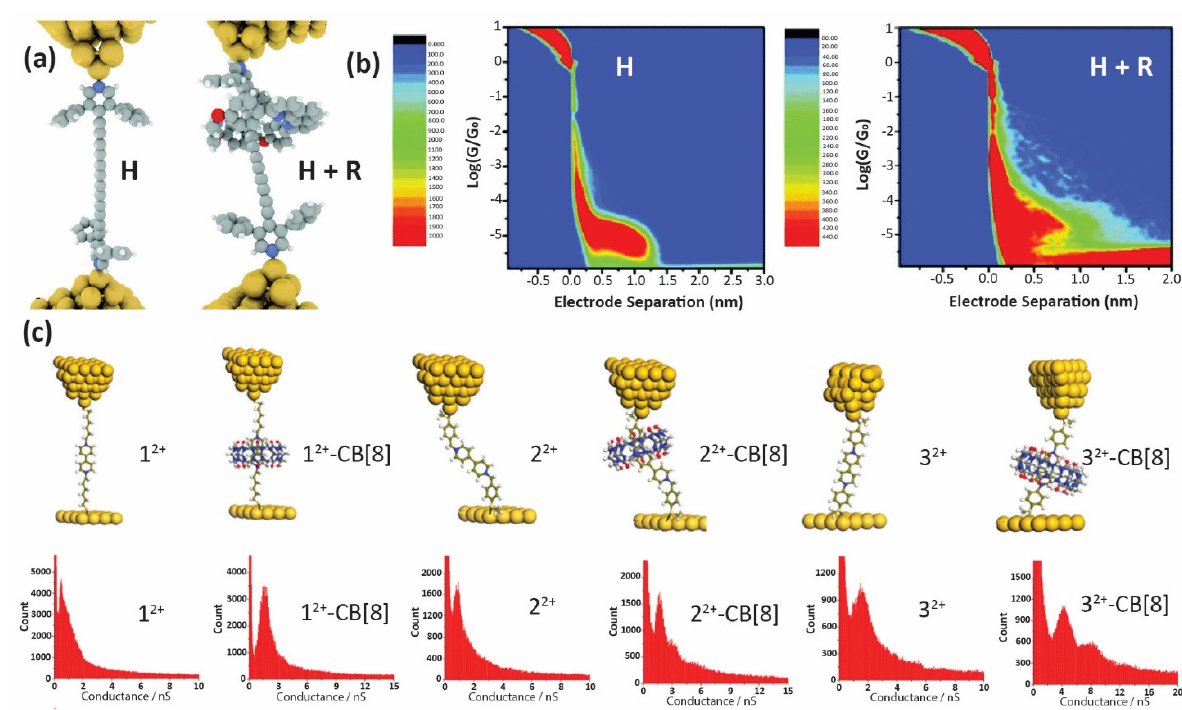
Figure 4. Host–guest interactions in single-molecule junctions. ( a ) Schematic representation of a guest hexayne dumbbell (H) and a hexayne-rotaxane complex (H + R). ( b ) Two-dimensional conductance histogram of H and H + R. Figures were reproduced with permission from reference [67]. Copyright 2017, Royal Society of Chemistry. ( c ) Illustration of different conformations of viologen guests and their cucurbit[8]uril host (top) with their corresponding 1-D conductance profile (bottom). Figures were reproduced with permission from reference [69]. Copyright 2016, American Chemical Society.